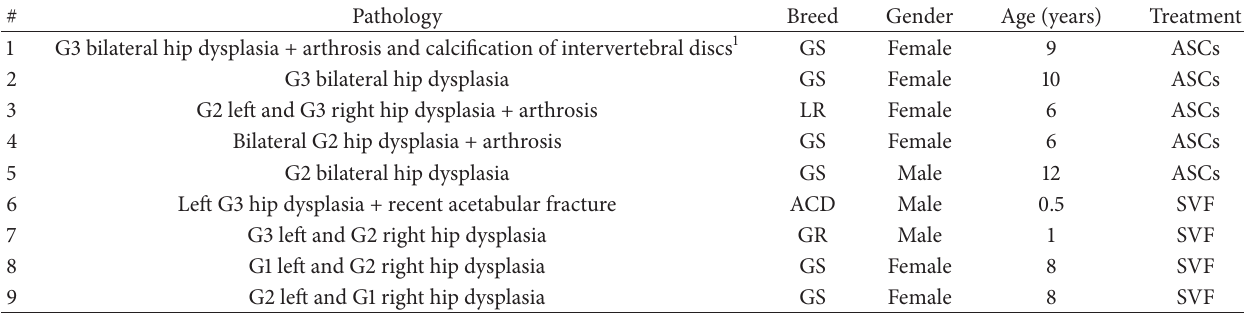
Table 1: Characteristics of dogs included in the study and treatment received. Treatment and type of cells used. #